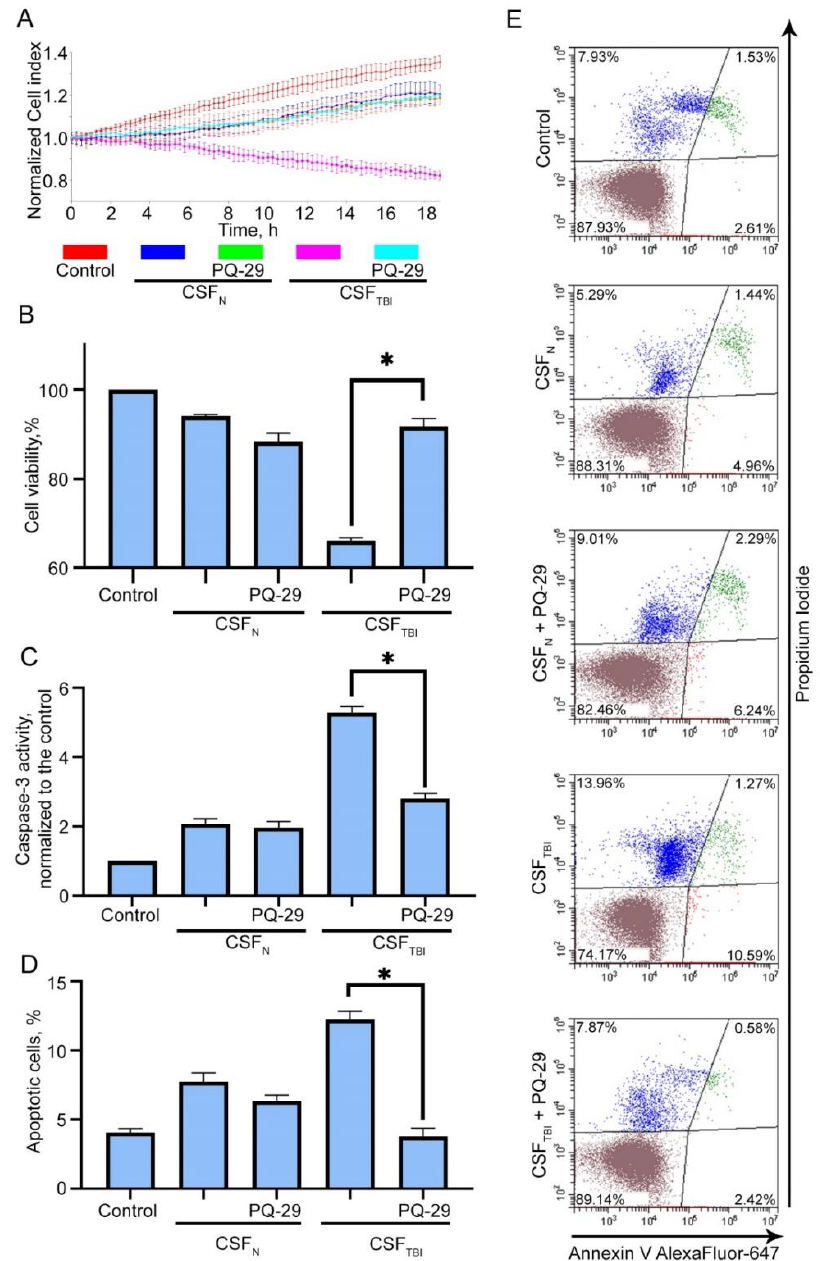
Figure 5. The treatment of traumatized animals with PQ-29 reduced the cytotoxicity of rat’s CSF. CSF samples were collected from traumatized and treated rats 34 days after TBI, mixed with growth medium (in volume ratio 3:7), incubated with C6 cells, and analyzed as described above. Control: CSF replaced by PBS; CSF N : growth medium containing CSF from non-traumatized rats; CSF TBI : growth medium containing CSF from traumatized rats; PQ-29: growth medium containing CSF from rats treated with PQ-29. ( A ) Cell index data produce using an xCELLigence device. The graph shows the dynamics of the C6 cellular index placed in a medium containing 30% of rat’s CSF. ( B ) The results of the MTT-test are presented. Cells were incubated with CSF for 24 h. ( C ) The results of the caspase-3 activity assay were demonstrated. Cells were incubated with CSF for six hours. ( D ) The results of Annexin V staining are presented. The measurement was provided with the aid of flow cytometry technique. Cells were incubated with CSF for six hours. ( E ) The distribution of the cell population according to flow cytometry data is presented. Data of three independent experiments presented as mean ± SEM. Statistical significance is indicated as * p < 0.05.